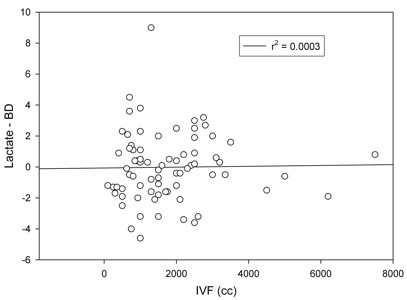
Base Deficit-Lactate Difference v. Intravenous Fluids.